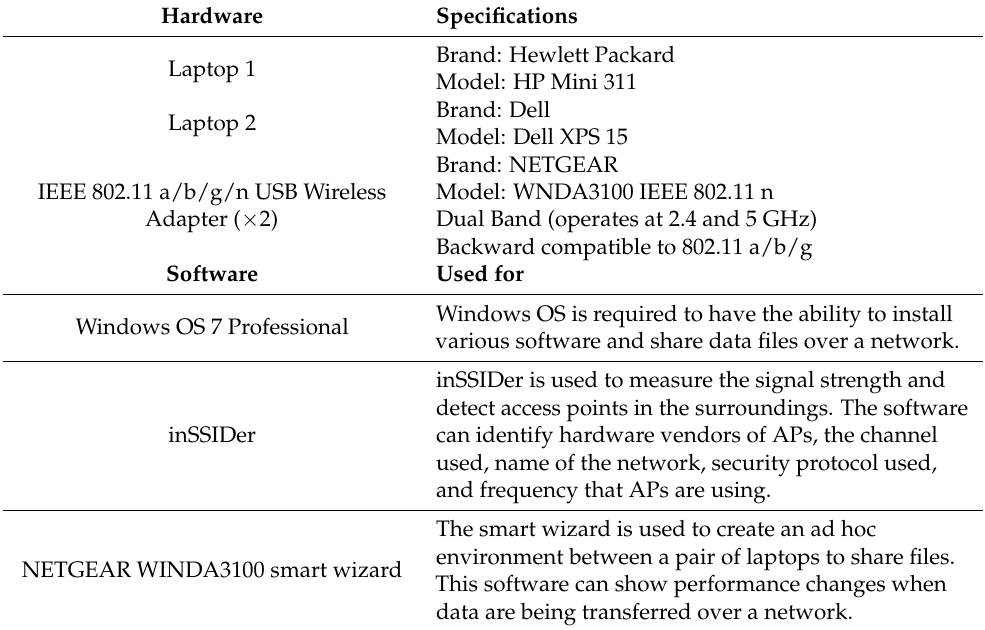
Table 3. Hardware and software